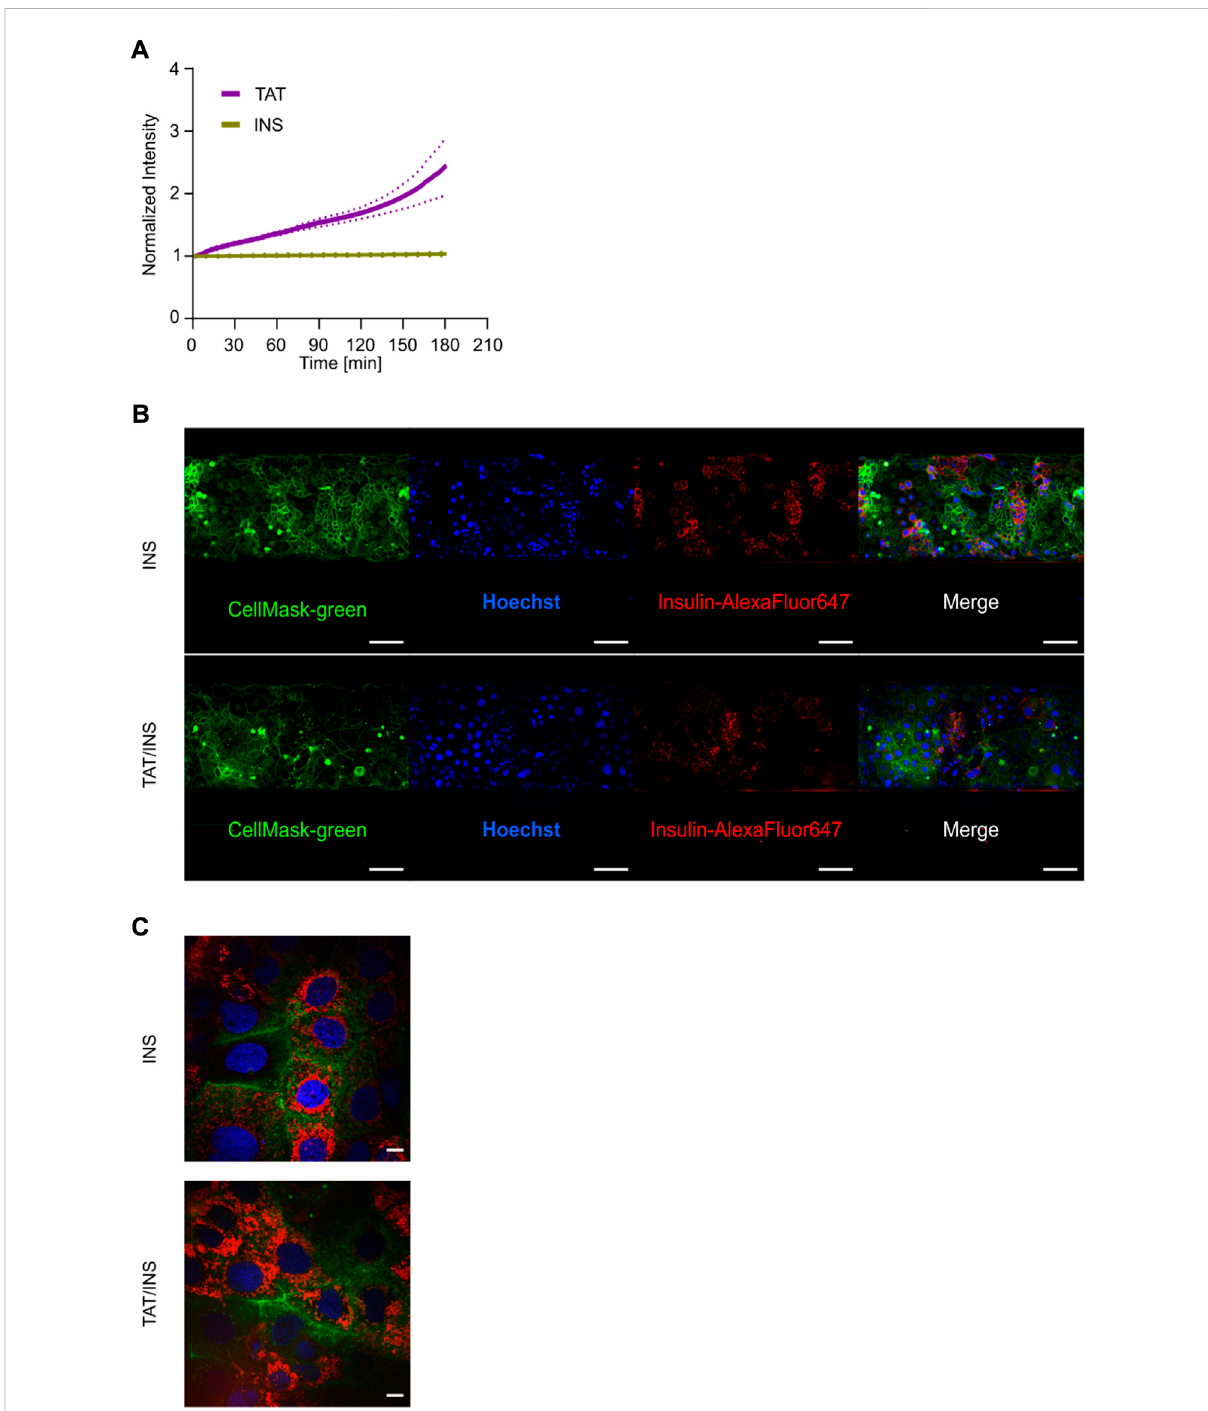
FIGURE 7 Multiplexed live cell imaging for assessing the intracellular localization and quantitative transport of Insulin. (A) Normalized intensities of INS (yellow)andTAT(purple)transportover3 h.Datare fl ecttheaverageofthreeindependentbiologicalreplicatesdepictedwiththeSEMindashedlines ( n = 3). (B) Live cell micrographs showing the intracellular distribution of INS (red) with (bottom) and without (top) co-incubation of TAT for 3 h in coculture tubules. Tubules were stained with CellMask-green (green) for representation of the plasma membrane and Hoechst (blue) as nuclei staining. Scale bar is 500 µm. (C) The uptake and intracellular localization of INS with (left) and without the addition of TAT after 3 h of incubation. Scale bar is 10